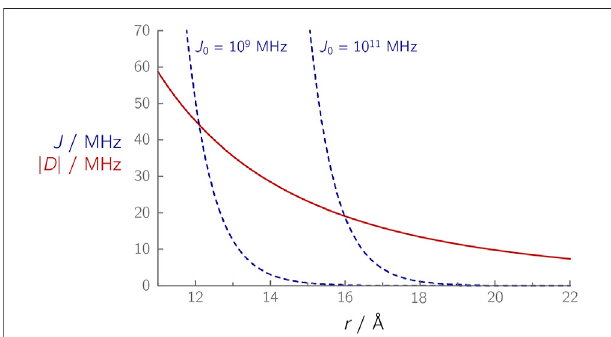
FIGURE 2 | Calculated distance dependences of | D ( r )| (red curve) and J ( r ) (dashed blue curves) in a radical pair. The spin – spin couplings D and J werecalculatedusing Eqs.3 and 7 ,respectively,using β =1.4 Å – 1 ,andthe J 0 values indicated next to the respective